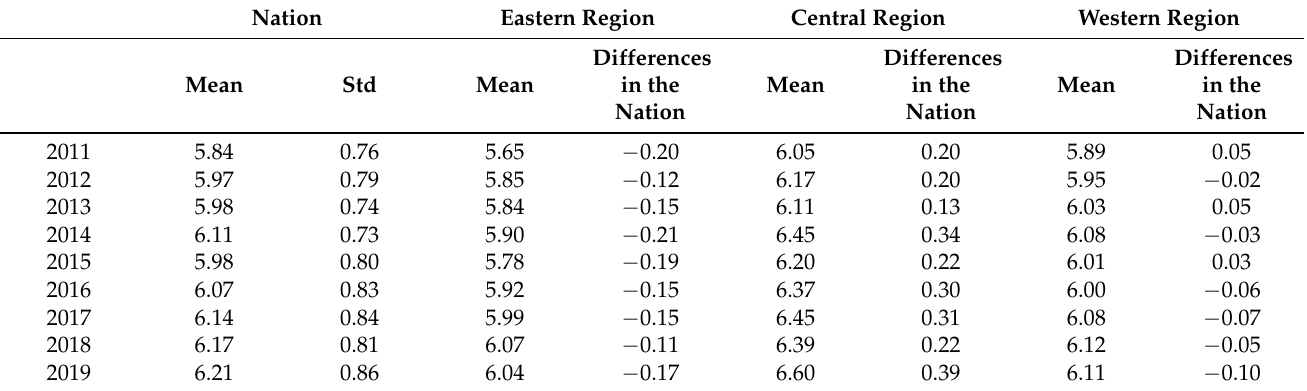
Table 1. Mortality levels and differences of nation and each region (unit: ‰). Nation Eastern Region Central Region Western Region Mean Std Mean